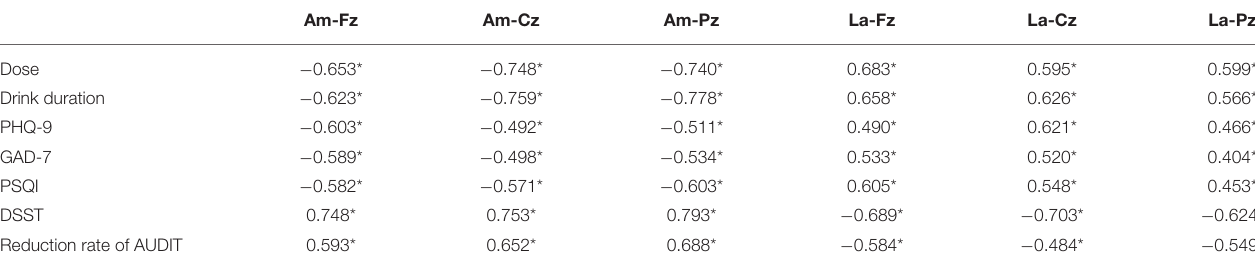
TABLE 3 | The association between ERP data and clinical data by Spearman simple correlation in follow-up AUD patients by Bonferroni correction ( N = 101).